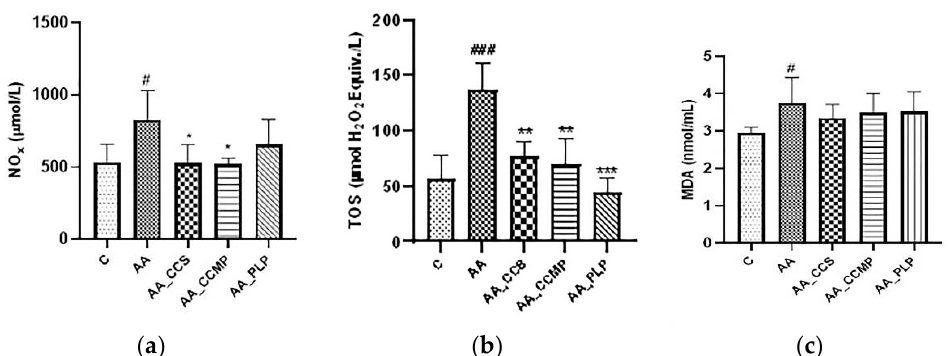
Figure 2. Nitrites and nitrates (NOx) ( a ), total oxidant status (TOS) ( b ) and malondialdehyde (MDA) ( c ) levels. Data are expressed as the mean ± SD for each group. # p < 0.05 and ### p < 0.0001 indicate a significant difference in comparison with the control group; * p < 0.05, ** p < 0.01 and *** p < 0.0001 indicate a significant difference in comparison with the AA group. Abbreviations: C, normal control group; AA, acetic acid group; AA_CCS, curcumin group; AA_CCMP, Col-CUR-MPs group; and AA_PLP, prednisolone group. The bars represent mean values with standard deviations.